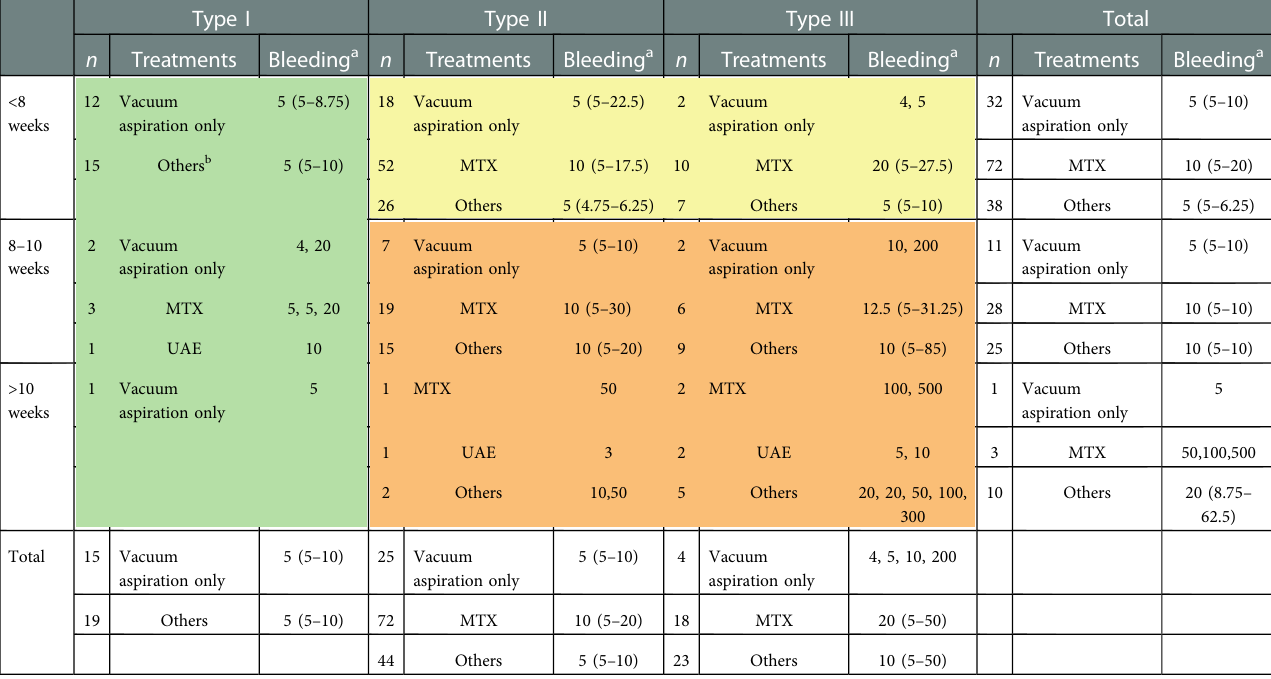
TABLE 4 Different management strategies according to the gestational age at diagnosis and cesarean section pregnancy